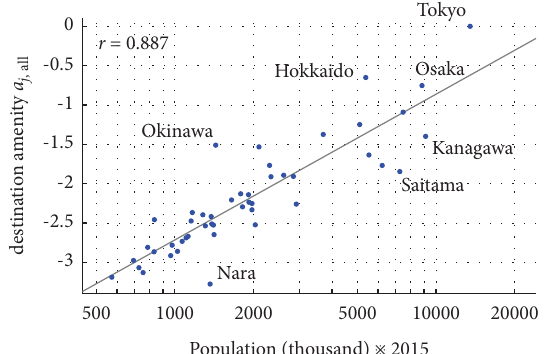
Figure 7: Relationship between the destination amenity a population.